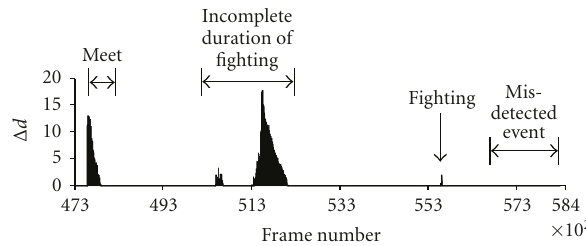
Figure 14: Detection results by K-means for Sequence 5 in the BEHAVE